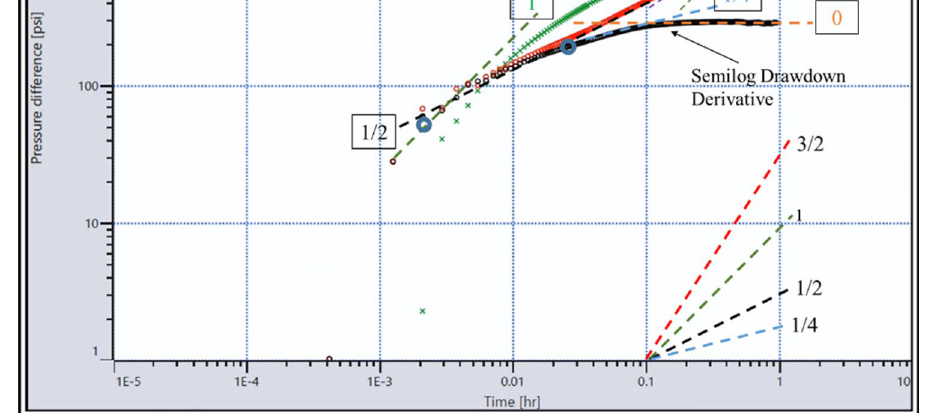
Fig. 9 Log–log diagnostic plot for the DFIT test (Cycle #3). The type of the flow, before and after closure, is determined based on the slopes which are shown by dashed lines. The ½ slope in the semilog draw- down derivative curve implies fracture linear flow. Drawdown derivative is (∆ t d∆ P /d∆ t ), and semilog derivative is referring to the Bourdet derivative